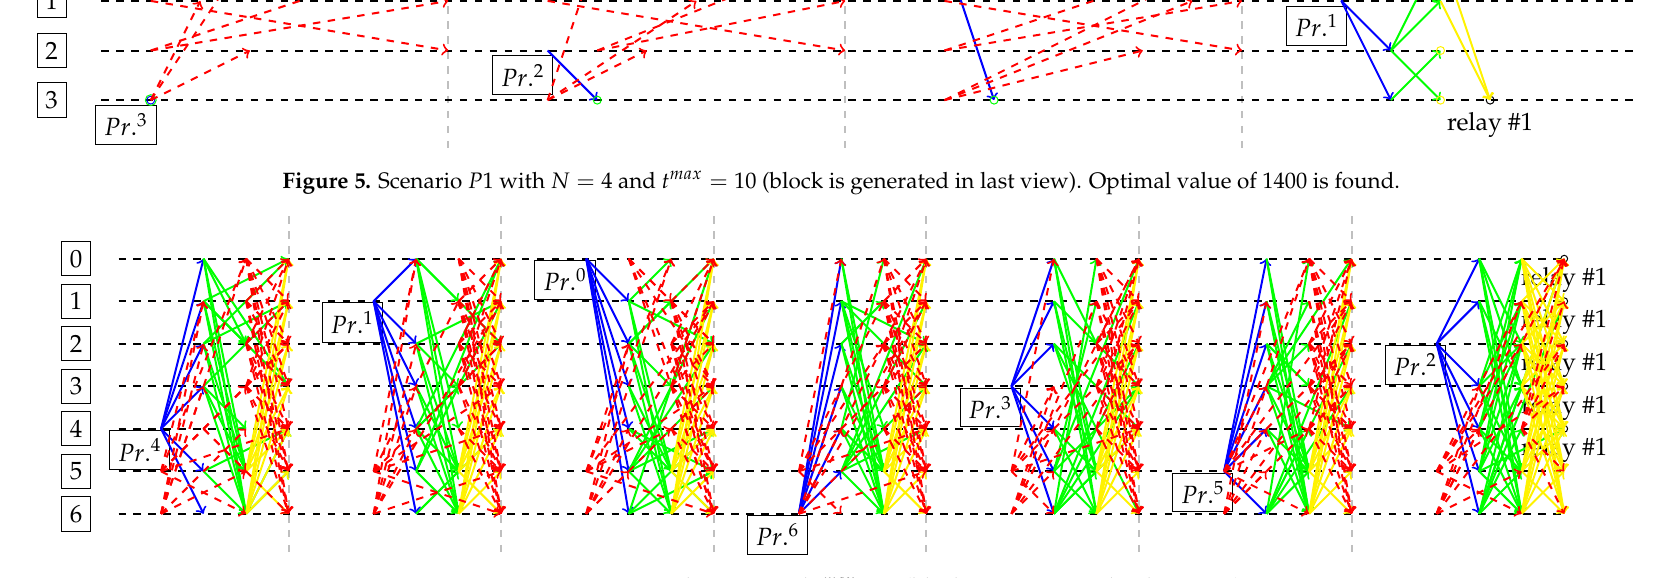
Figure 6. Scenario P 5 with N = 7 and t max = 5 (blocks are generated in last